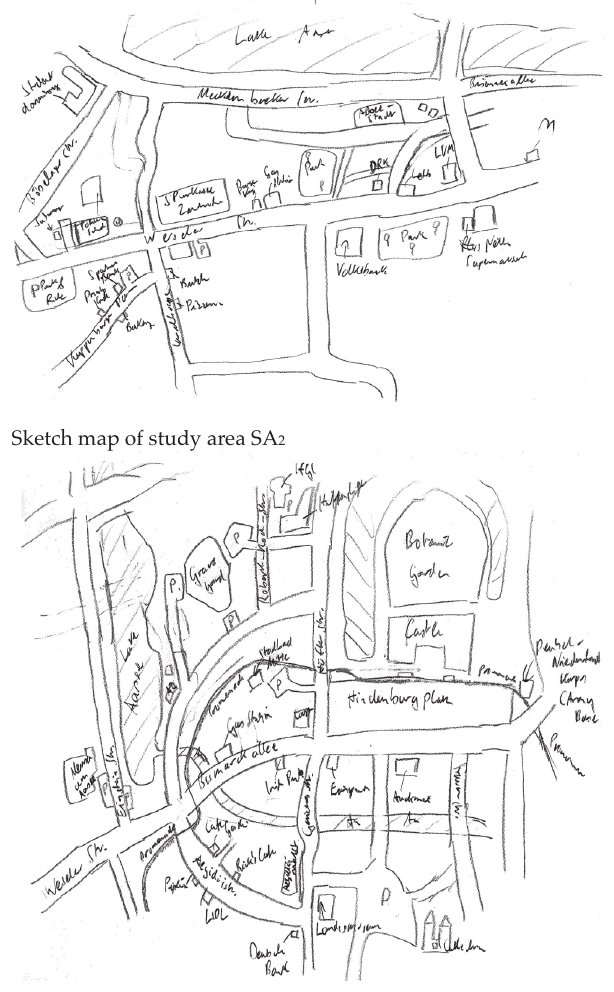
Figure 8: Two valid sketch maps from the same